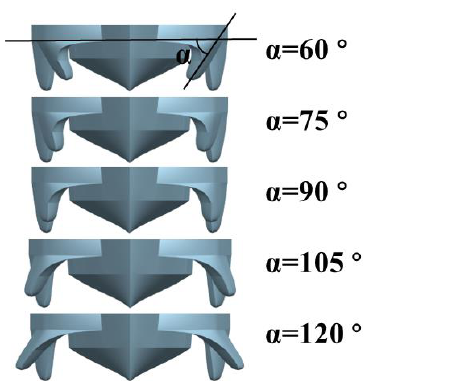
Figure 2. Pentamaran front outrigger inclination configuration.